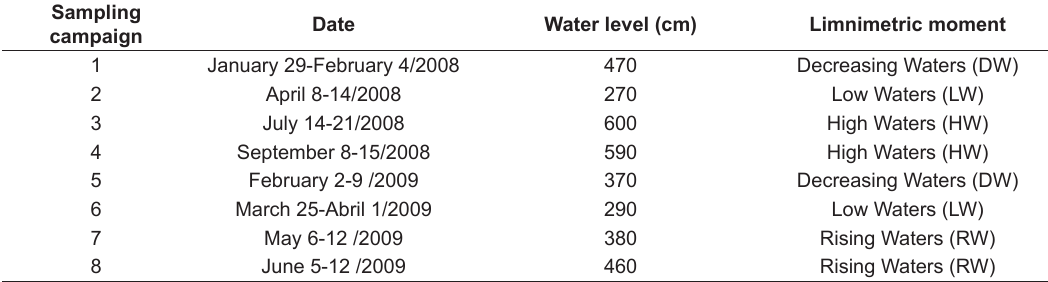
Table 1. Sampling campaigns in the Ayapel Swamp Complex (ASC) over different limnimetric moments from January 2008 to November